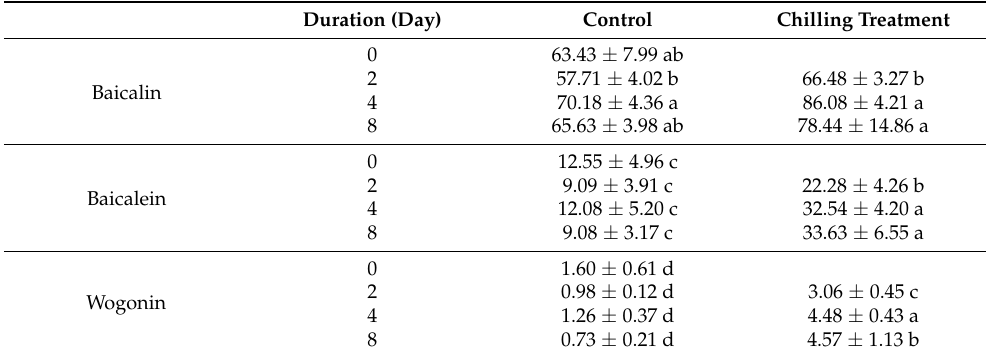
Table 1. HPLC analysis of flavones in roots of S. baicalensis plantlets after chilling treatment. Duration (Day)